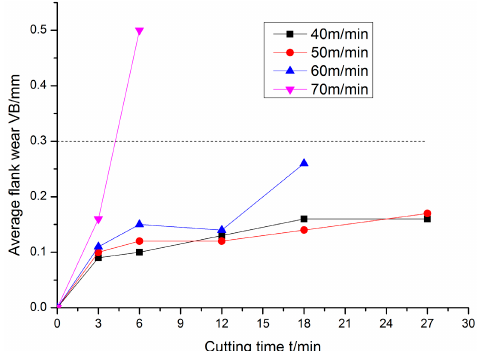
Figure 13. Evolution of VB against cutting time at different cutting speeds (feed rate of 0.1 mm/r, depth of cut of 1.0 mm).